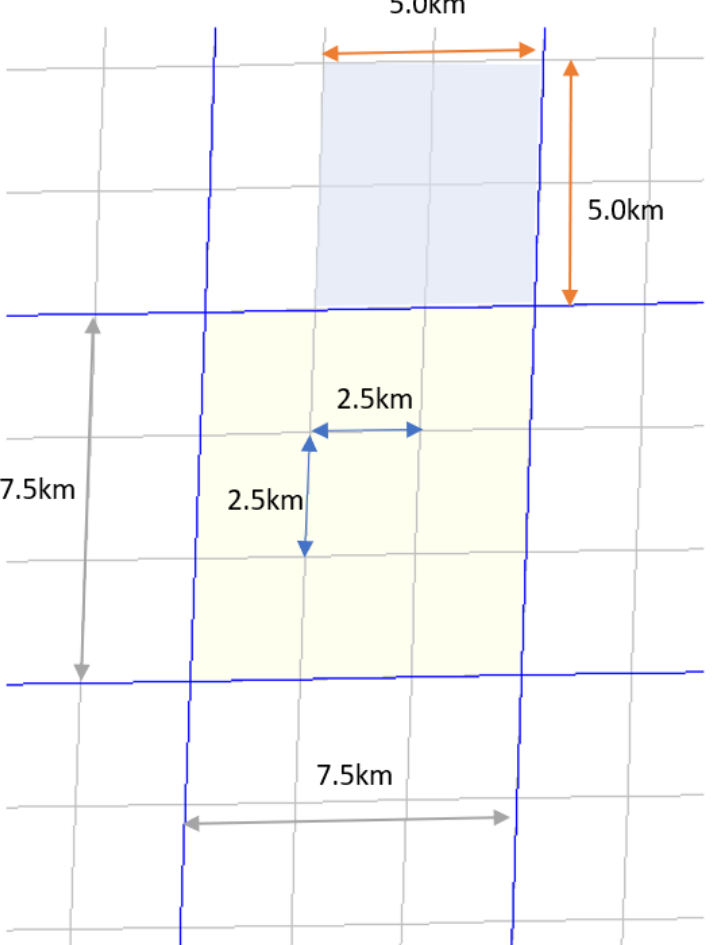
Figure 3. SWAN model grid discretisation for the dense (approx 2.5 km), medium (approximately 5 km) and coarse (7.5 km) computational